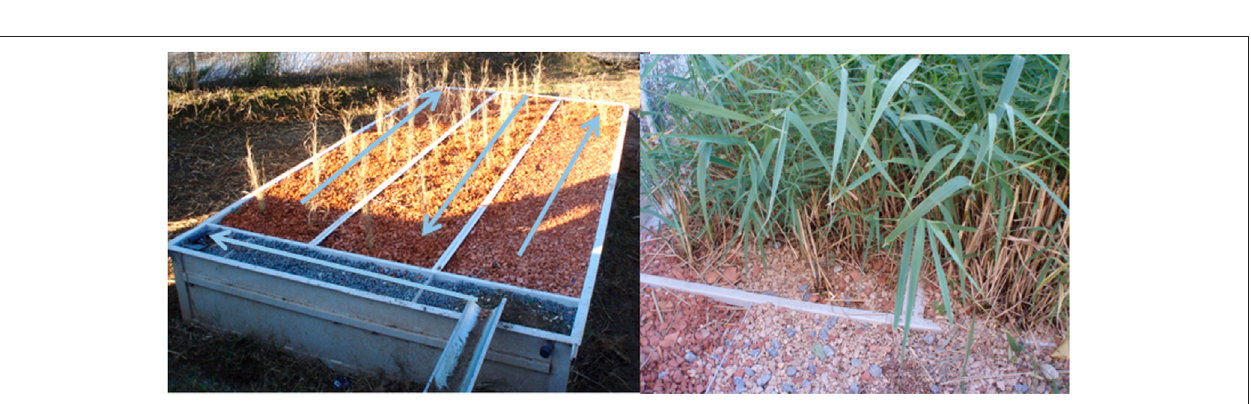
FIGURE 3 | HFCW pilot: general view and Phragmites australis detail.